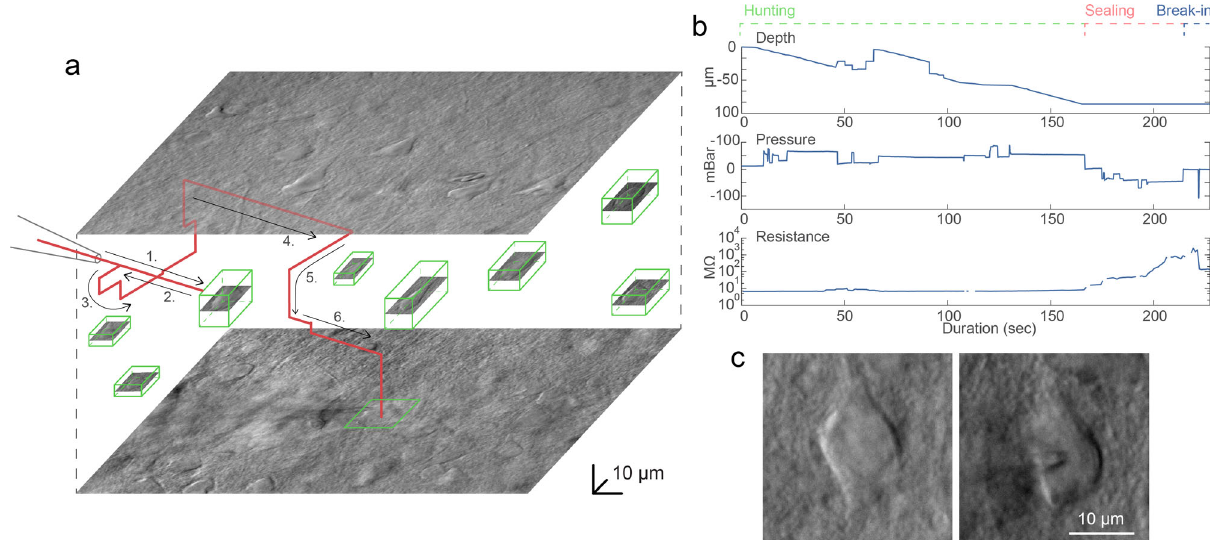
Fig. 4 A representative example of a visual patch clamping procedure. a Trajectory of the pipette tip (red line) with obstacle avoidance (numbered) in the tissue and the spatial location of the detected cells (green boxes). The steps of the avoidance algorithm are the following. 1: The pipette is moved forward in the initial trajectory until an obstacle is hit. 2: The pipette is pulled back. 3: The pipette is moved laterally in a spiral pattern until the resistance is back to normal. 4: The obstacle is passed. 5: The pipette is readjusted to the trajectory. 6: The approaching is continued. b Plots of the depth of the pipette tip in the tissue, the applied air pressure, and the measured pipette tip resistance during the approach. c Image of a cell before and after performing patch clamp recording on it. Source Data is available as a Source Data fi